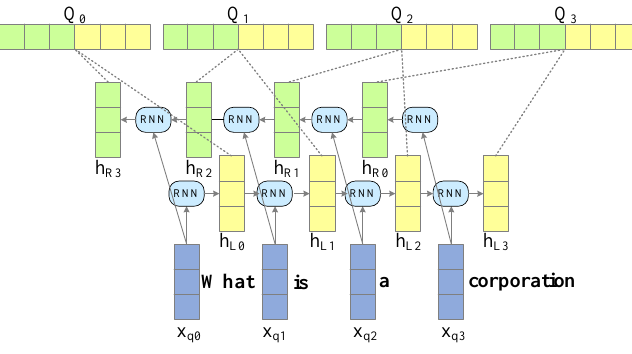
Figure 7. Word-level encoding for